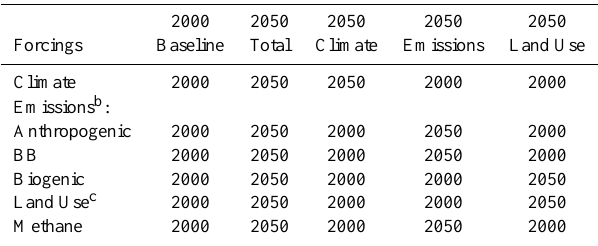
Table 3. List of simulations a